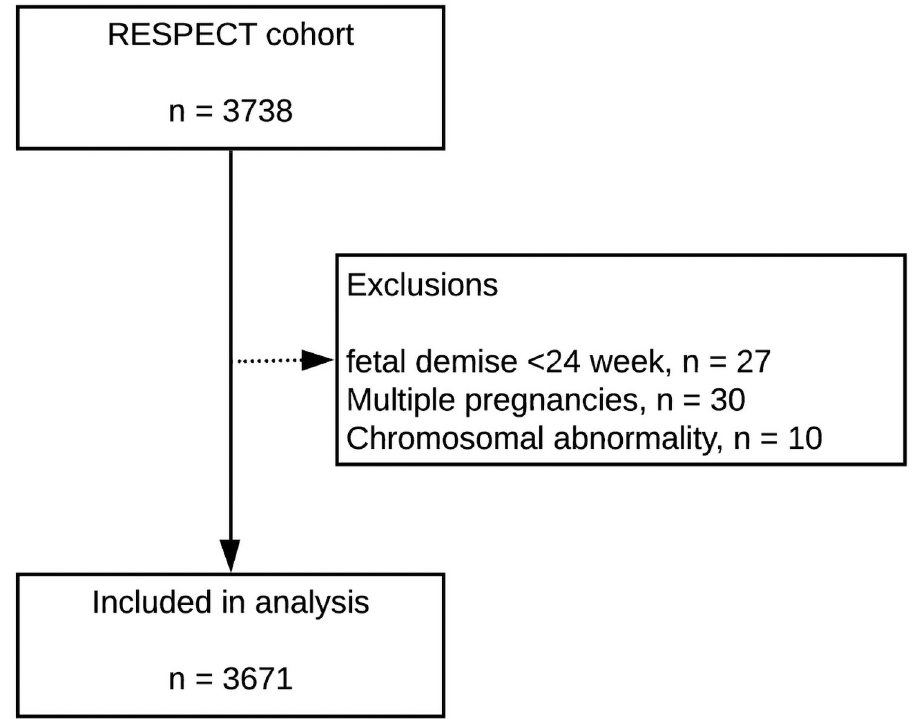
Fig 1. Flowchart of the study